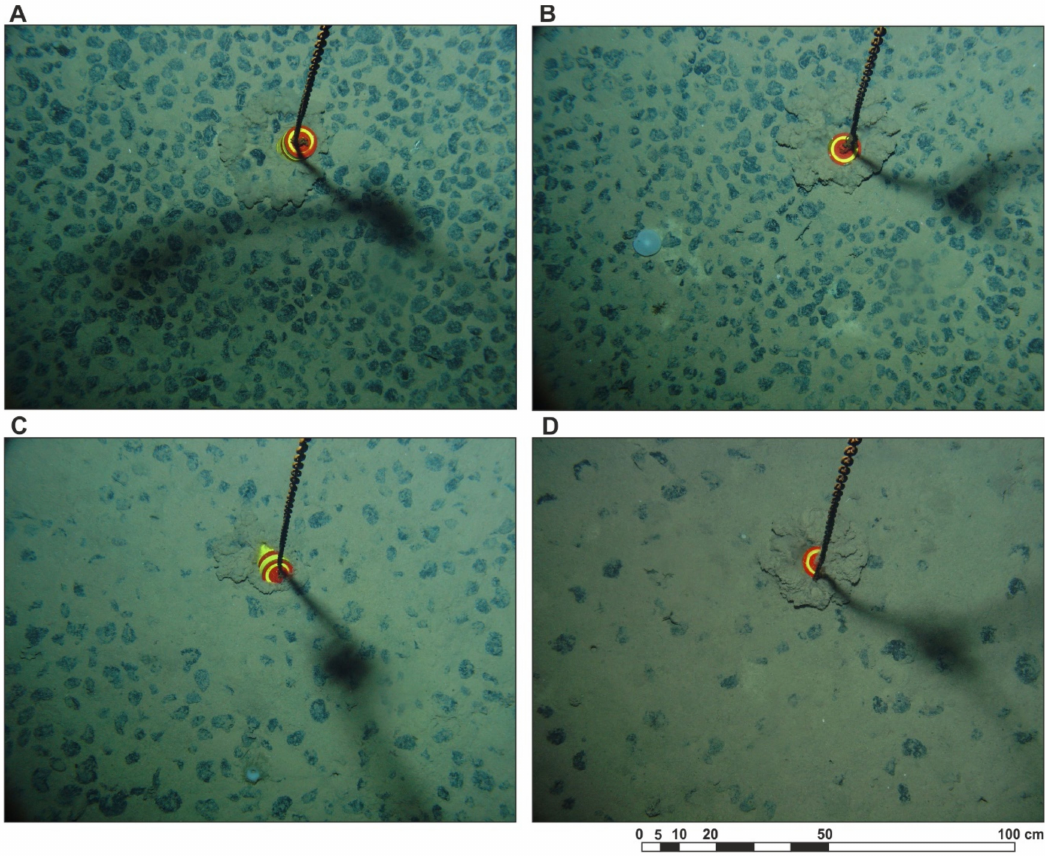
Figure 5. Examples of seafloor photographs showing different degrees of coverage of nodules with sediments(thevaluesoftheordinalvariablesaregiveninparentheses): ( A )—lowcoverage(1), ( B )—medium coverage (2), ( C )—high coverage (3), and ( D )—very high coverage